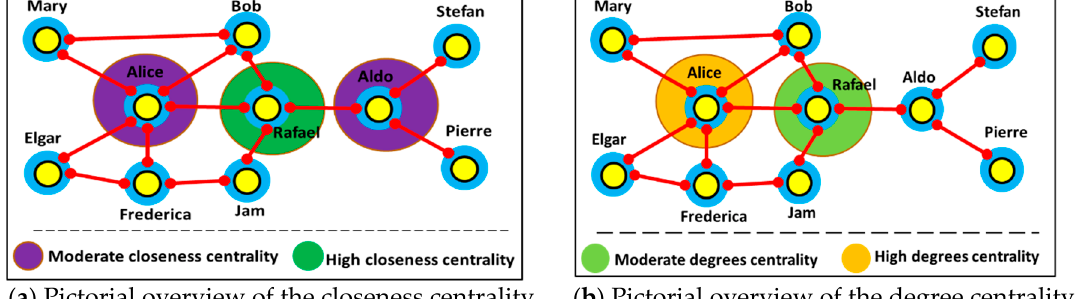
( a ) Pictorial overview of the closeness centrality (CC) in a SN.